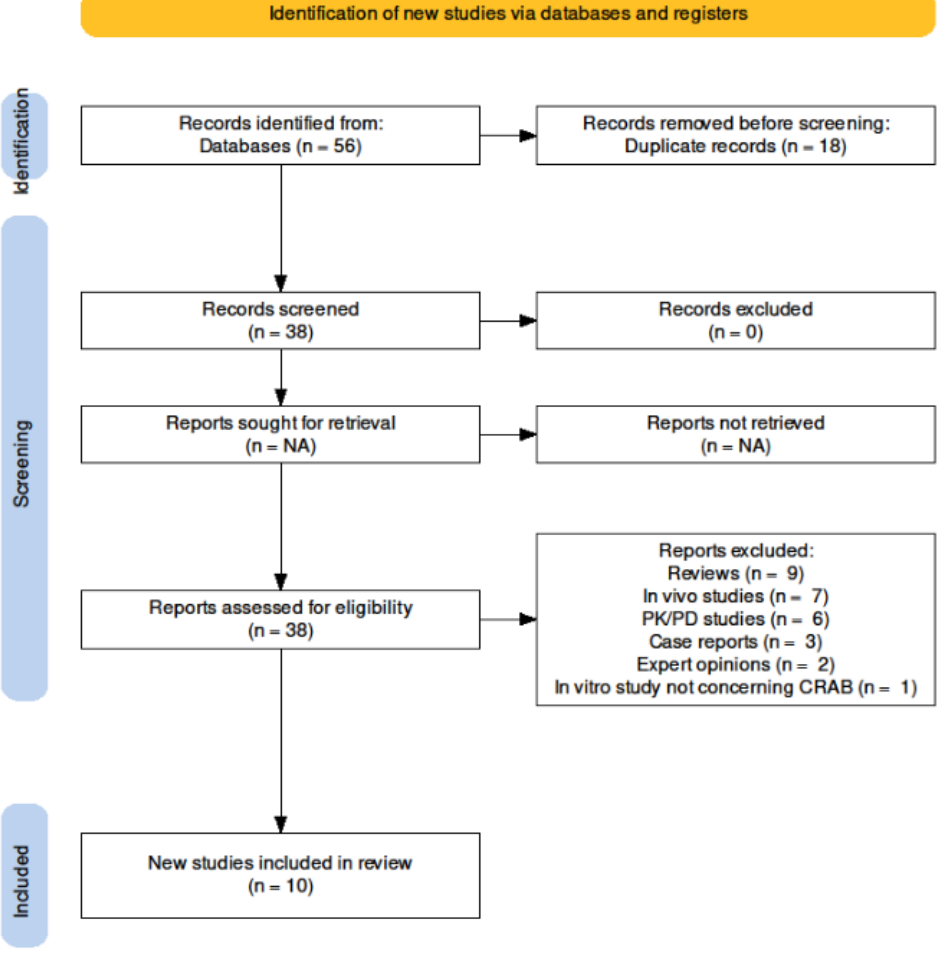
Figure 1. Search strategy.